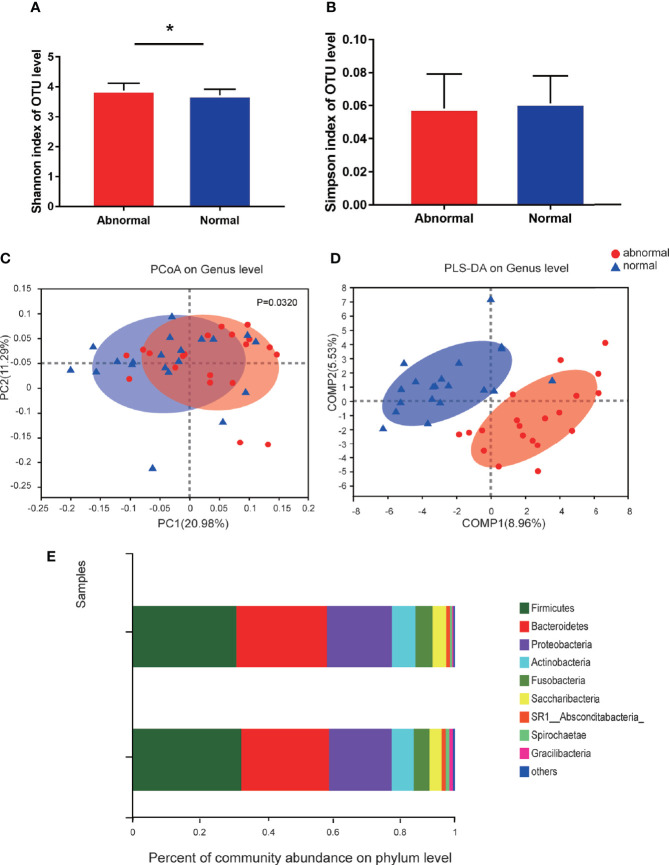
Diversity and species composition of salivary microbiome in the Abnormal and Normal Groups. (A) Chao Index of operational taxonomic unit (OTU) level, *P<0.05. (B) Simpson index of OTU level. (C) Weighted UniFrac PCoA of genus level, P<0.05. (D) partial least squares discriminant analysis (PLS-DA) of genus level showed more obvious separation in the horizontal coordinate axis. (E) Community bar plot analysis showing the top 10 phyla with highest abundance.